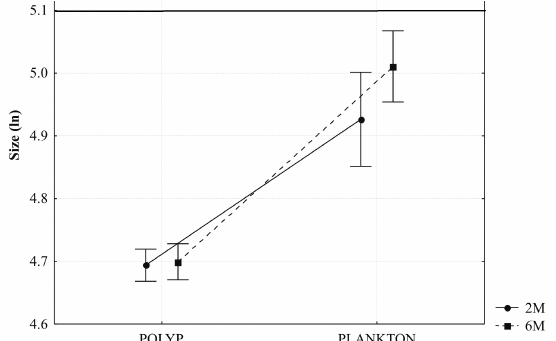
Fig. 4- First-order interaction between sites (polyps of Carijoa riisei and plankton) and depth on ln transformed mean of prey size at Porto de Galinhas beach